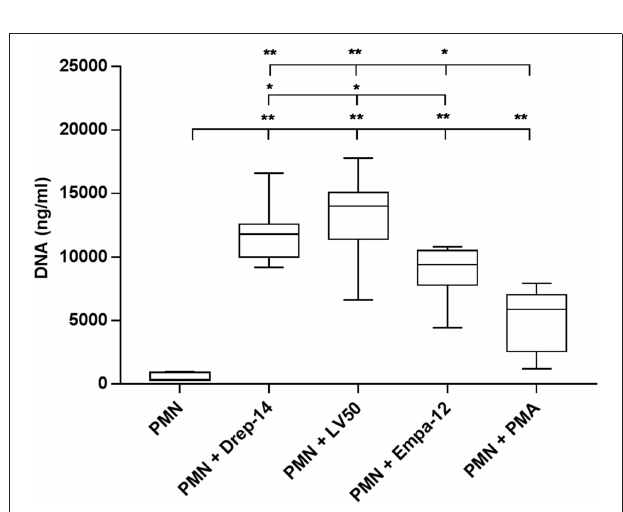
FIGURE 4 | Leishmania promastigotes induce DNA release. Neutrophils (2 × 10 5 ) were infected with Leishmania strains at a 10:1 ratio or with 100nM PMA as a positive control (0nM PMA was the negative control) for 18h at 37 ◦ C in presence of 5 % CO 2 . Then, EcoR1 and HindIII (20 U/mL) were added to the medium to digest the DNA trapped in the released NETs. After 4h of incubation at 37 ◦ C, the cells were centrifuged and released DNA was quantified in the culture supernatant by DNA quantification using a dsDNA High Sensibility Assay Kit on a Qubit. Data are shown as mean values from seven donors ± SD. Pair wise comparisons of PMN vs. each strain-infected PMNs or vs. PMN-PMA, and of infected PMNs between each other were performed using the Mann–Whitney test; * p < 0.05 and ** p < 0.01 indicate statistically significant differences at the indicated p